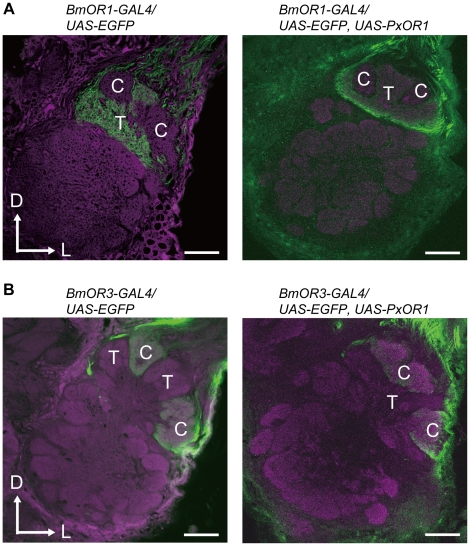
Ectopic expression of PxOR1 does not modify the axonal projections of pheromone receptor neurons.The axon terminals of bombykol (A) or bombykal (B) receptor neurons in the absence (left) or presence (right) of PxOR1 expression were visualized with EGFP followed by anti-GFP immunostaining (green). Background staining was carried out with Alexa Fluor 555 (left) or an anti-synaptotagmin antibody (right) to visualize neuropil structures (magenta). Representative confocal sections are shown. C: cumulus, T: toroid, D: dorsal, L: lateral. Scale bars: 50 µm.